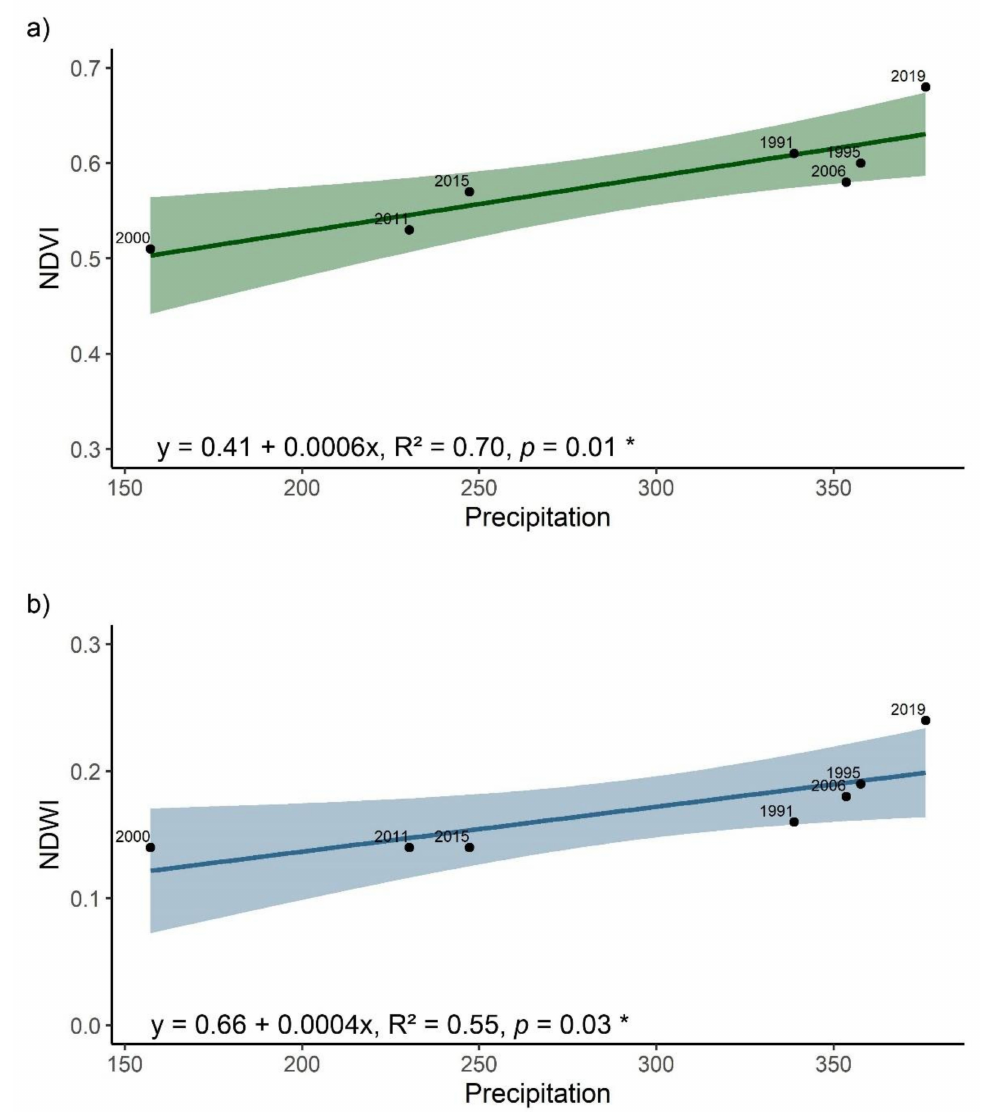
Figure 8. Relationship between the NDVI ( a ) and NDWI ( b ) and precipitation in the last three decades. Significance levels: * p < 0.05, ** p < 0.01, *** p < 0.001.